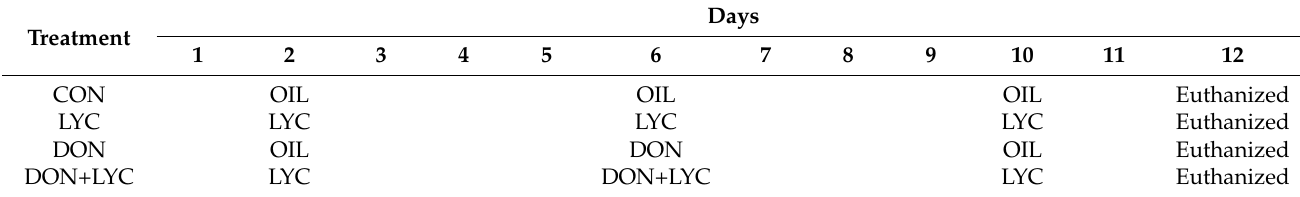
Table 1. Experimental